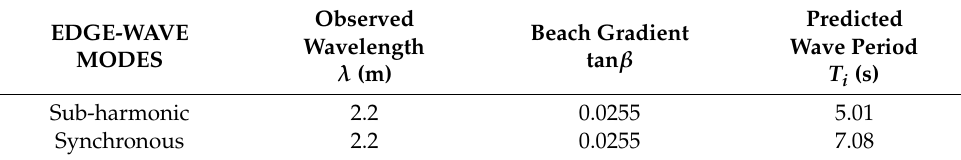
Table 3. Predicted incident wave peak